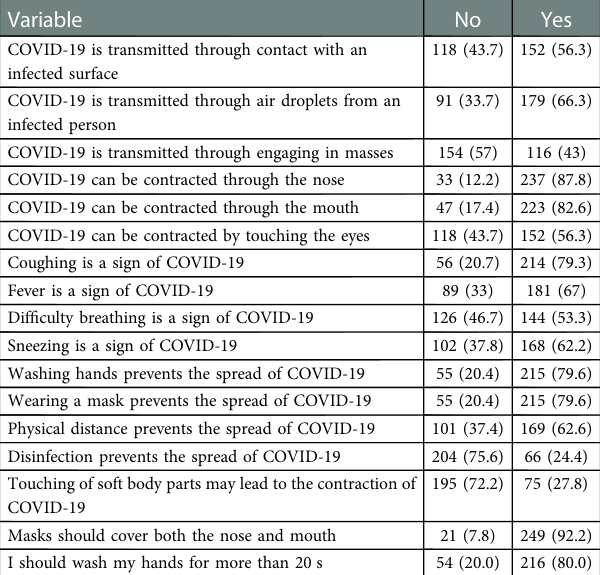
TABLE 4 Logistic regression for analysis of factors relating to knowledge TABLE 6 Knowledge assessment of COVID-19 and prevention measures. of the respondents about COVID-19 and the prevention measures. Variable p -value AOR 95% CI for AOR Lower